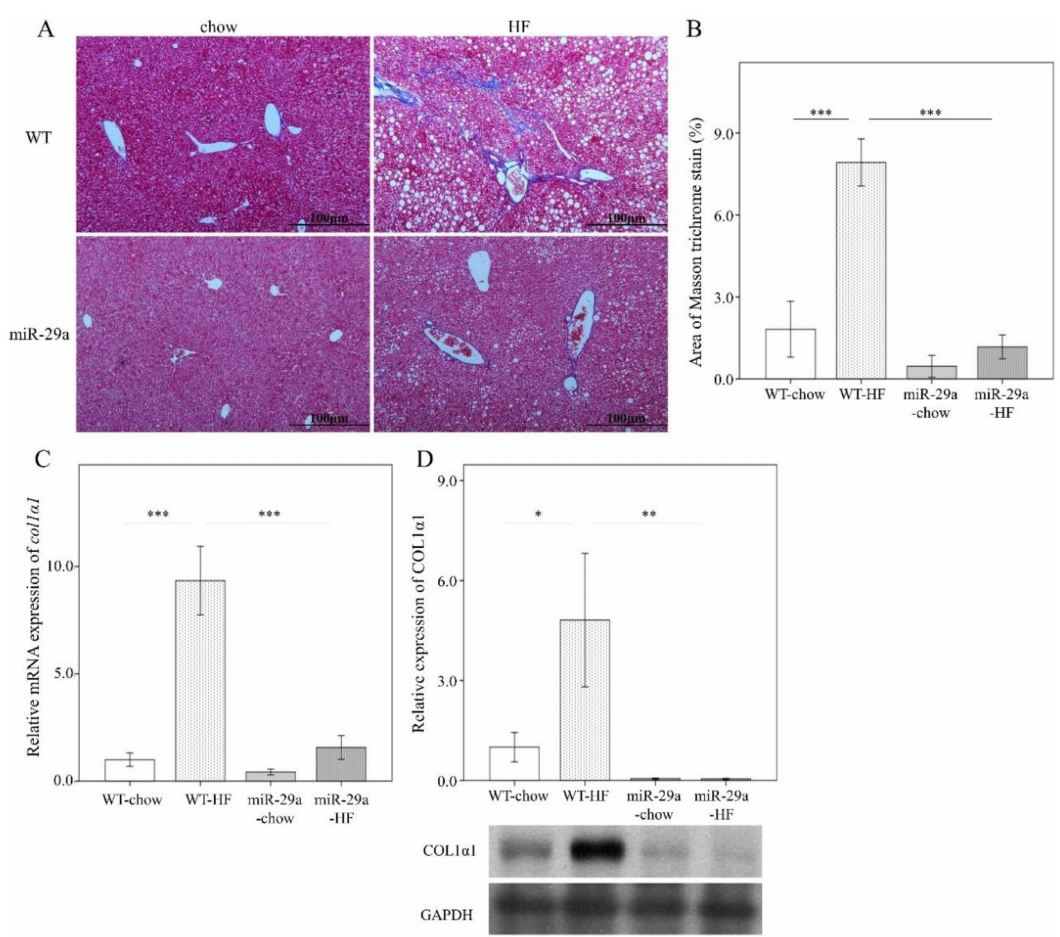
Figure 4. Overexpression of miR-29a reduces liver fibrosis in the context of chronic HFD. Paraformaldehyde-fixed para ffi n-embedded liver tissue was used to determine collagen fiber accumulation using Mason’s trichrome stain. Liver tissue stored at − 80 °C was used for RNA and protein extraction for subsequent qPCR and Western blot experiments, respectively. ( A ) Representative Masson’s trichrome stain image of each group. Blue color indicates positive signal of collagen fiber. ( B ) Positive signal percentage quantified using ImageJ. ( C ) mRNA expression level of col1 α 1 , with β -actin level as normalization control. ( D ) Representative immunoblotting bands of COL1 α 1 protein abundance and densitometric results, with glyceraldehyde 3-phosphate dehydrogenase (GAPDH) as the loading control. For the imaging study, data were collected from five fields of view of each specimen and five to eight specimens for each group. For qPCR and Western blot, five to seven specimens were used for each group. Data are expressed as mean ± SE. * p < 0.05, ** p < 0.01 and *** p < 0.001 between the indicated groups. WT, wild type mice. HFD, high-fat diet. miR-29a, mice harboring overexpression of